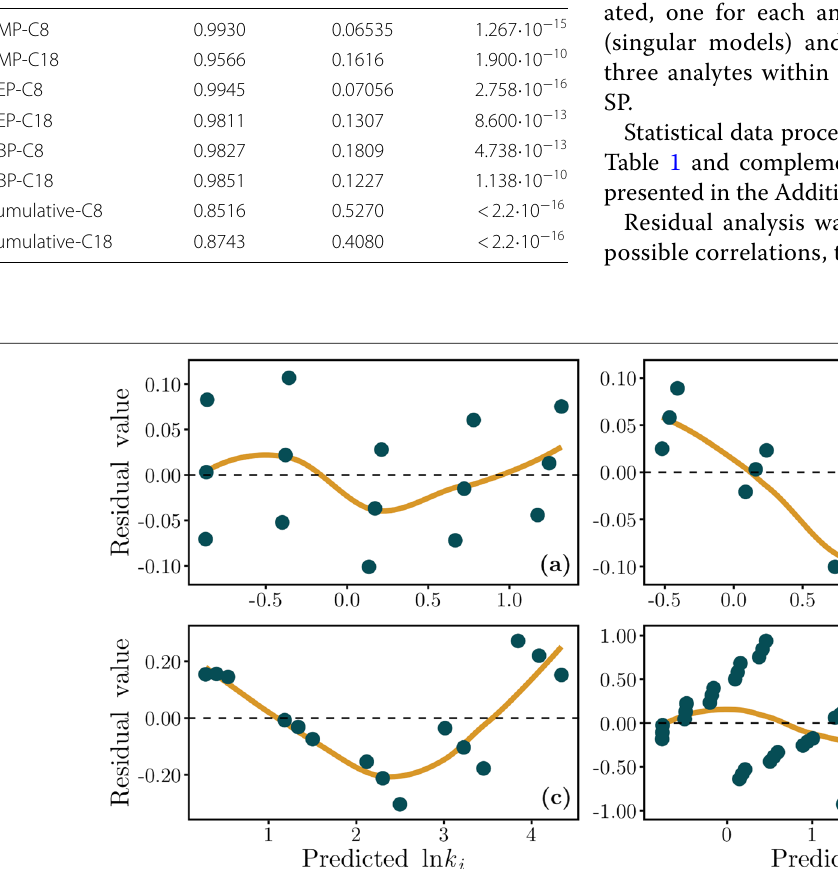
Fig. 2 Residual analysis of all models on SP C8. a DMP model, b DEP model, c DBP model, d cumulative model. The yellow line indicates the trend of the